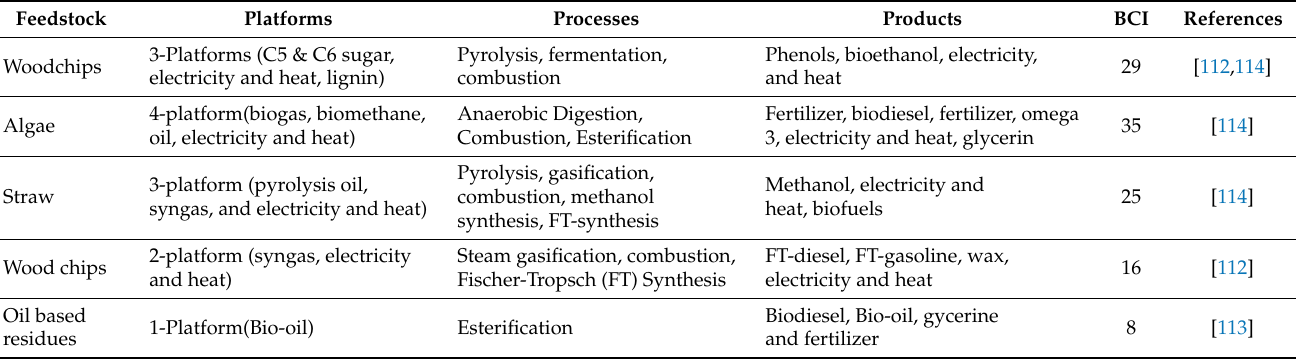
Table 3. Examples of biorefinery integration to produce two or more platforms.